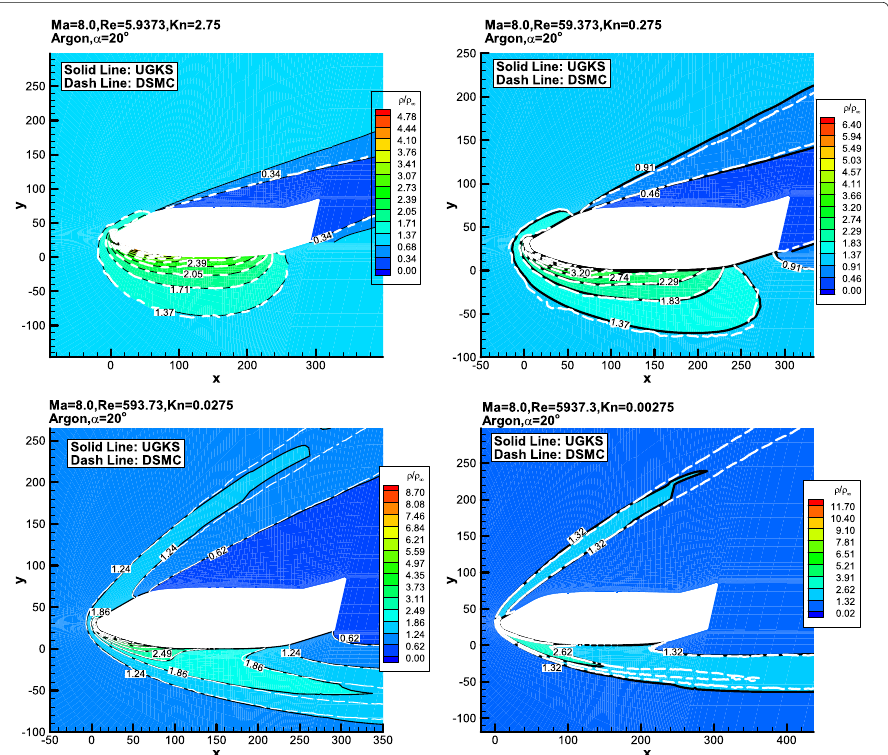
Fig. 3 Comparison of density flow fields. Solid black line: UGKS; Dash white line: